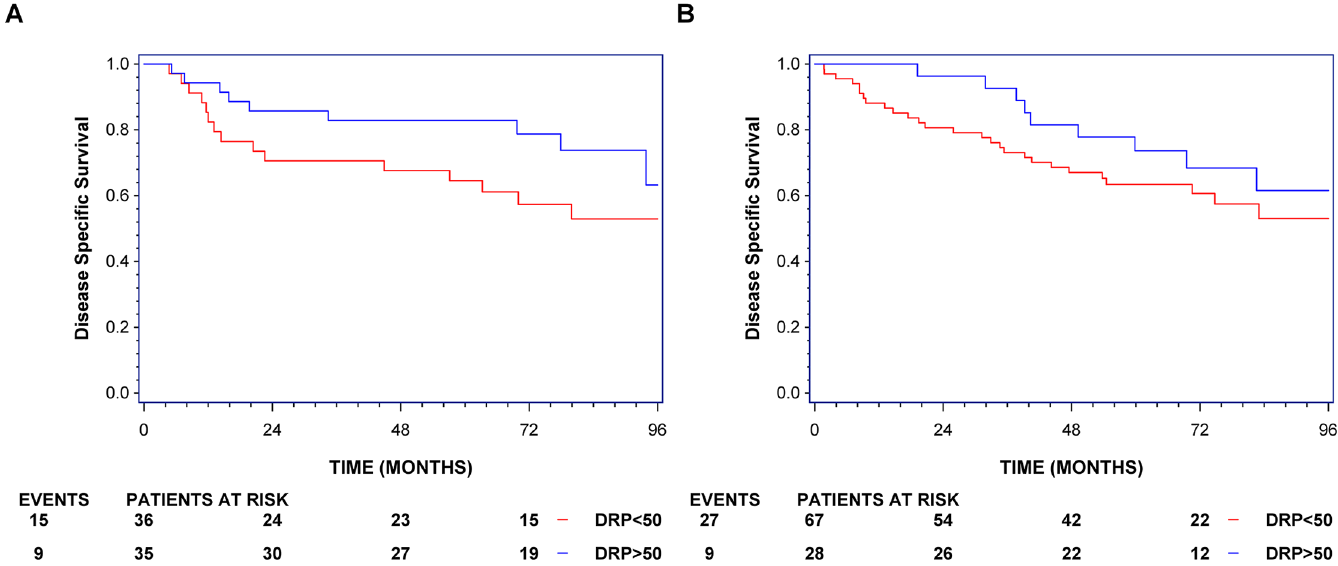
Fig 1. Kaplan-Meier curves of the cohorts receiving adjuvant cisplatin and vinorelbine, disease-specific survival. The curves show the cohort receiving adjuvant chemotherapy (ACV) in JBR.10 (1A) divided by a score of 50 and of the RH-cohort also receiving ACV (1B) divided by a score of 50. Underneath each curve is a description of events and patients at risk at different time points. Red: Combined cisplatin and vinorelbine score > 50, predicted high-likelihood responders to ACV; black: Combined cisplatin and vinorelbine score (cid:20) 50, predicted low-likelihood responders to ACV.